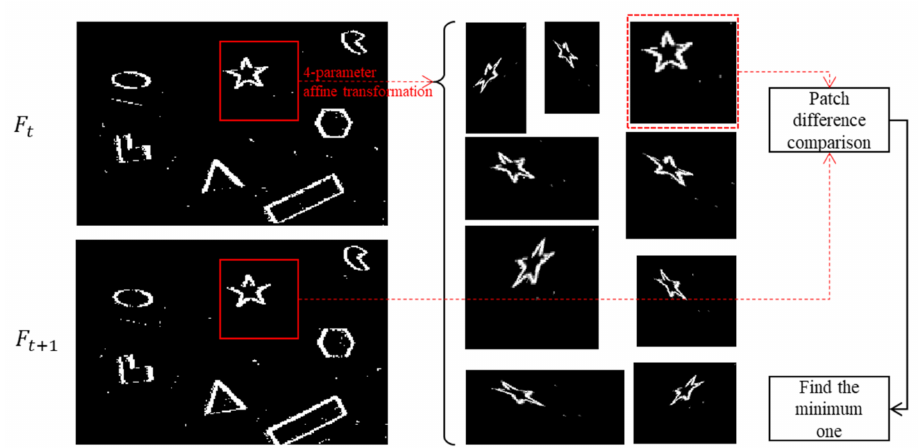
Figure 3. Illustrative example for multiple hypothesis testing with four-parameter affine transforma- tion